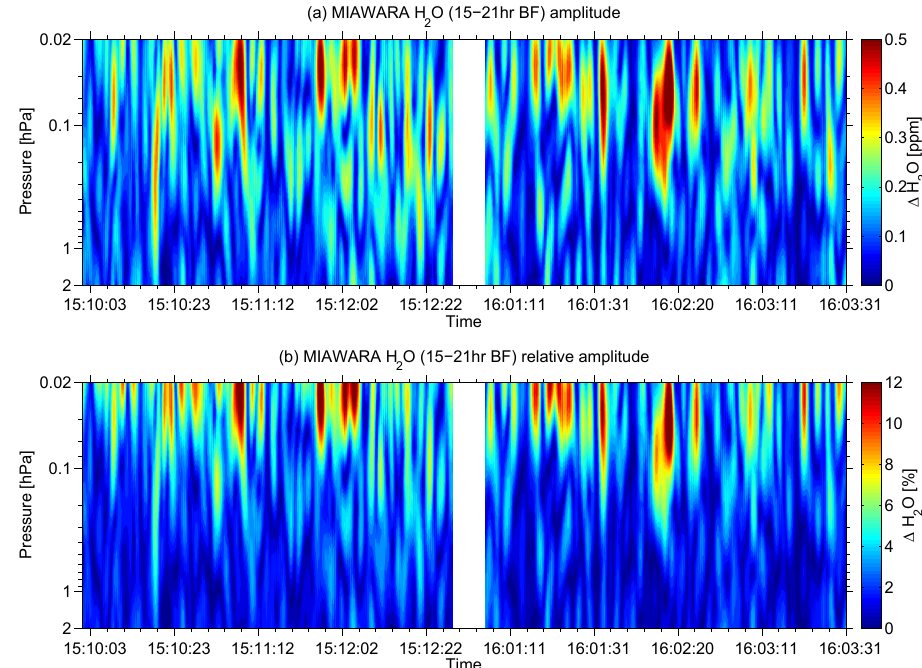
Figure 8. Same as Fig. 7, but here the time period from October 2015 to March 2016 is shown. The measurement gap between 28 December 2015 and 4 January 2016 is indicated by the white bar.